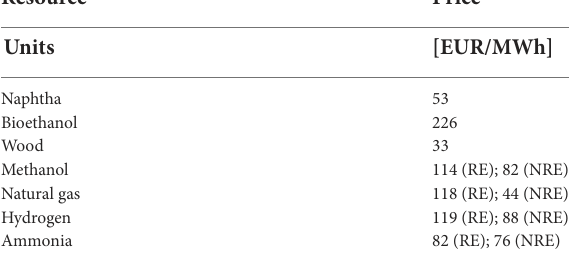
TABLE 2 Prices of the resources input to the conversion technologies represented in Figure 1 for the satisfaction of the non-energy demand. “RE” refers to the resource produced from renewables, while “NRE” to a production based on fossil resources. The values of the carbon intensity per typology of resource and the references of the values provided can be found in Limpens (2021).